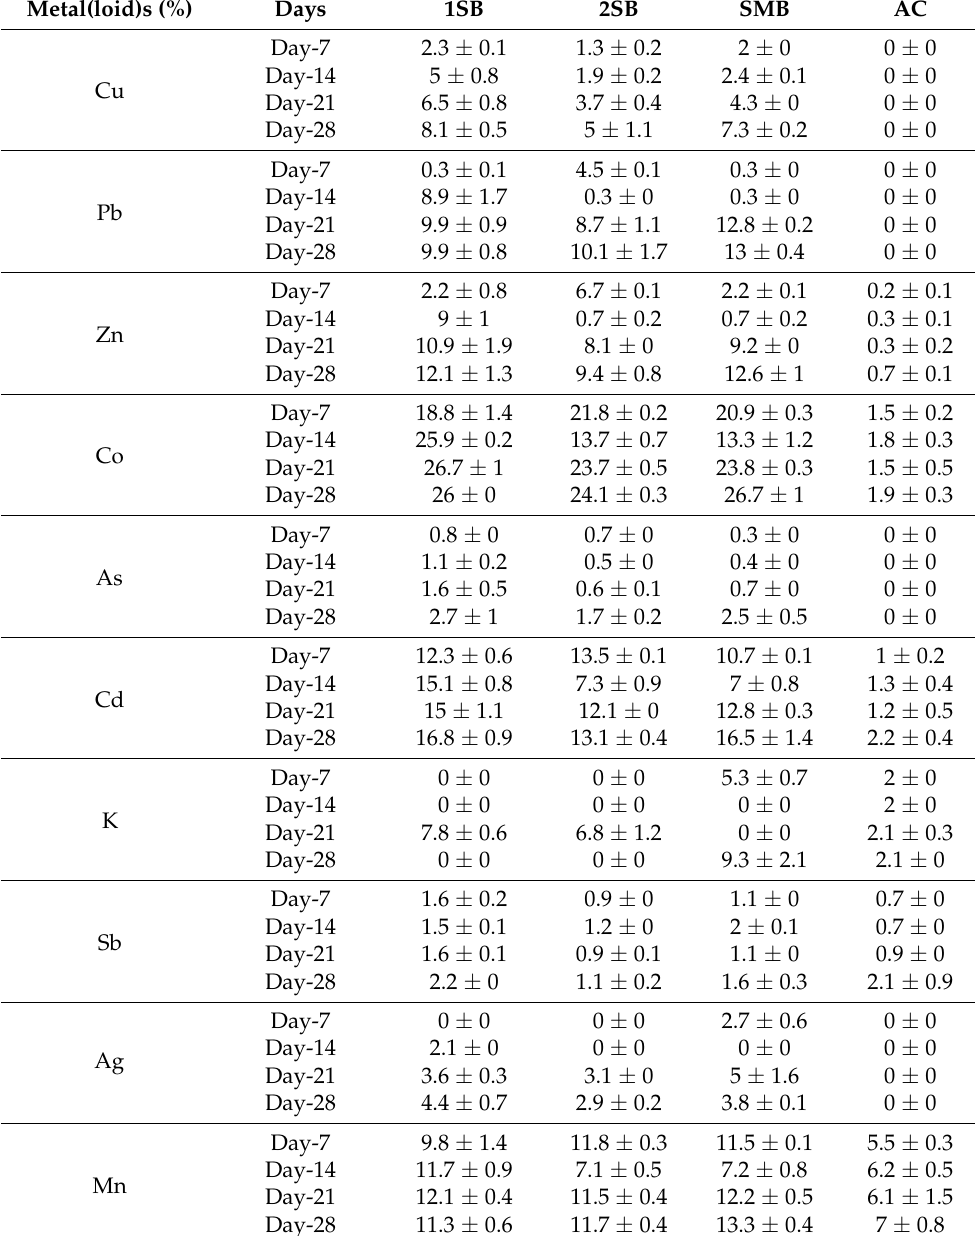
Table A4. Percentages of the metal(loid)s extracted from the Neves Corvo waste rock by T. pacifica via one-step bioleaching (1SB), two-step bioleaching (2SB), spent medium bioleaching (SMB), and the abiotic control (AC). Values are the average of duplicate flasks ± standard